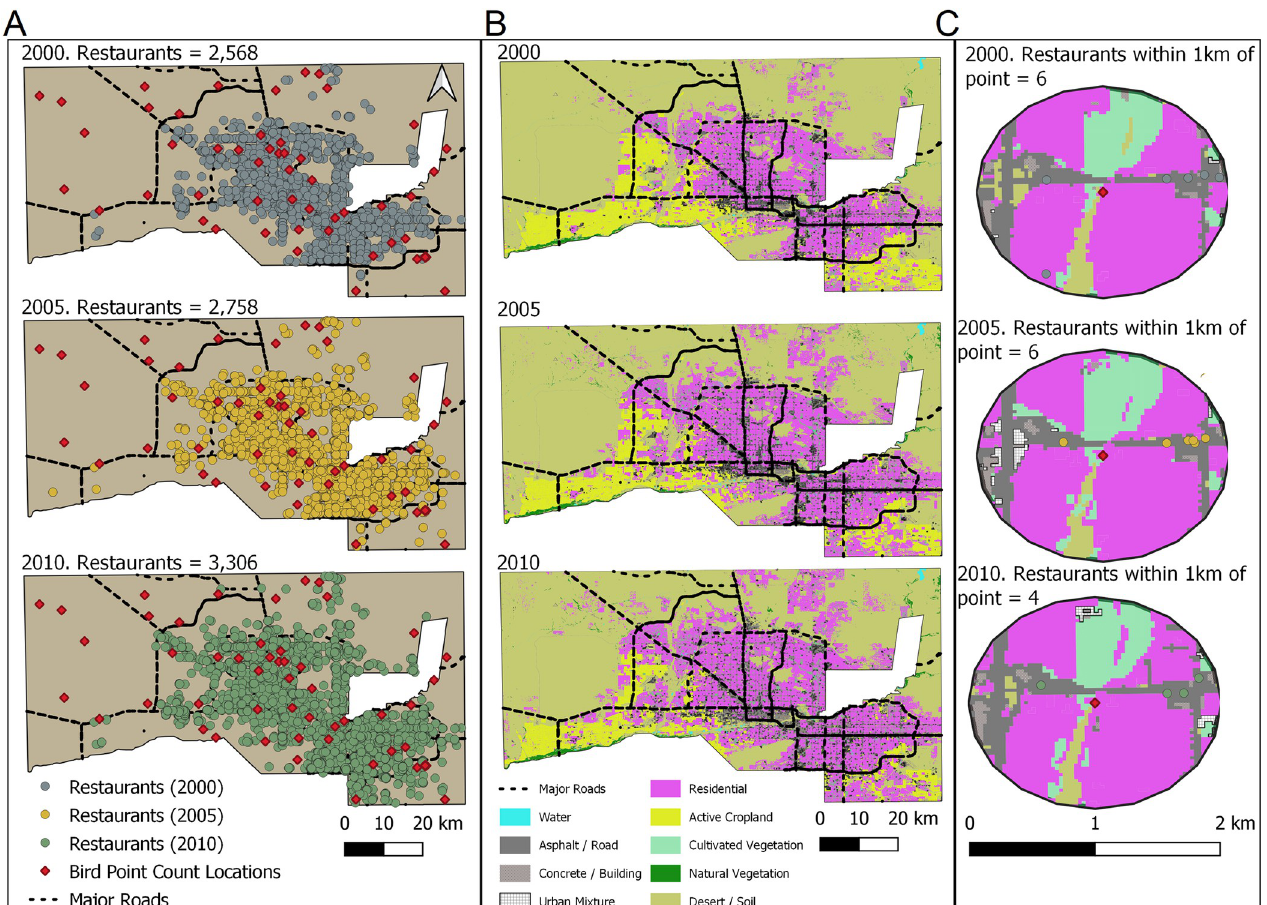
Fig 1. Within the CAP LTER study area in Phoenix, Arizona, the number of restaurants and distribution of restaurants are shown (A) along with the land-use land-cover for 2000, 2005, and 2010 (B). Additionally, a sample point count is shown to display how we measured the number of restaurants within 1 km of each point count for 2000, 2005, and 2010 as well as the land-use within 1 km of the point count for each time period (C).